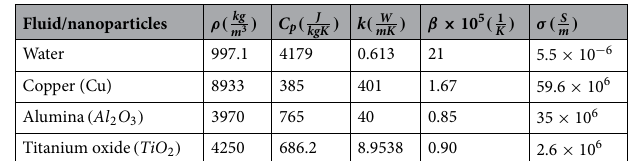
Table 3. Thermophysical features of water and nanoparticles 60